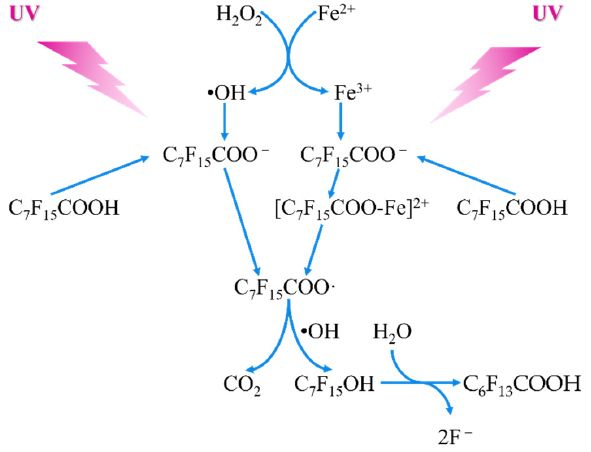
Figure 4. A two-stage mechanism for the degradation of PFOA in the UV–Fenton process. Reprinted with permission from reference Heqing Tang, Qingqing Xiang, Min Lei, Jingchun Yan, Lihua Zhu, Jing Zou, 2012, [132].